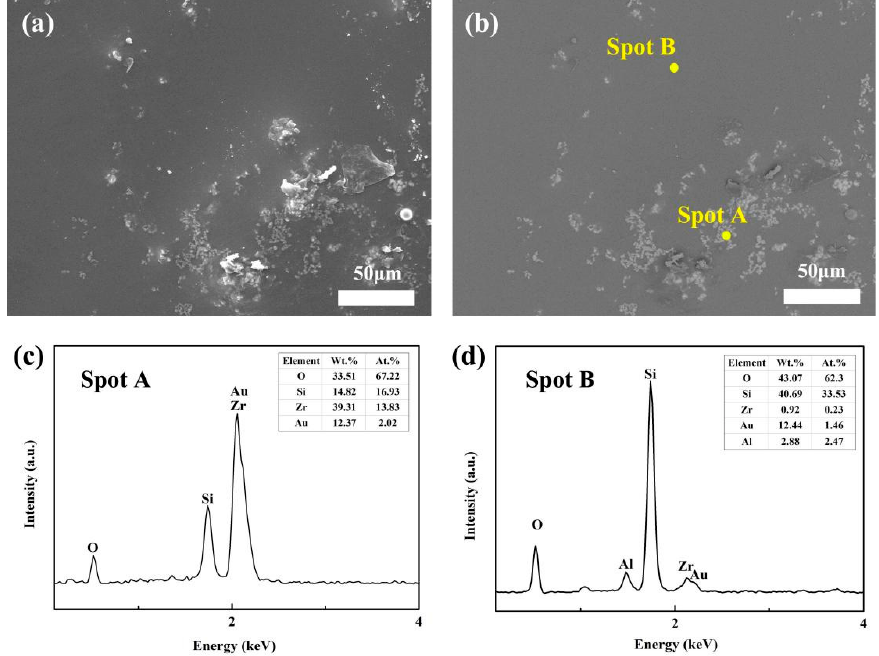
Figure 8. The surface morphology and EDS results of the sample with 30 wt.% ZrSi 2 in the ZrSi 2 -SiC outer coating after 92 h oxidation at 1500 °C. ( a ) SEM image; ( b ) BSEM image; and ( c , d ) EDS results.